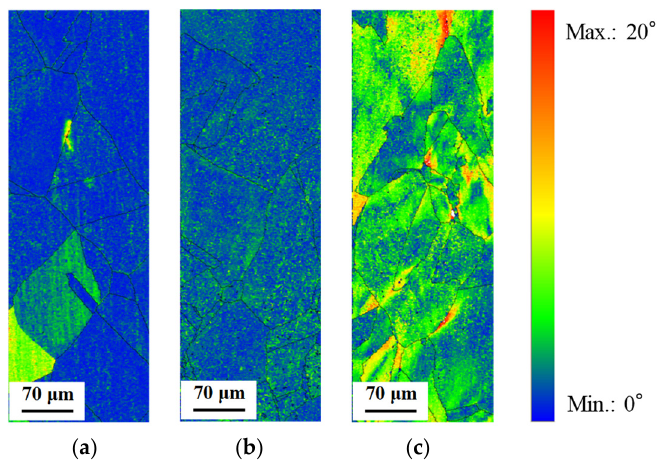
Figure 13. Grain reference orientation deviation (GROD) maps of heat-treated C1020 specimens after low cycle fatigue test. ( a ) Stress amplitude: 50 MPa (fatigue cycle: 7,786,201 cycles); ( b ) stress amplitude: 75 MPa (fatigue cycle: 235,144 cycles); ( c ) stress amplitude: 100 MPa (fatigue cycle: 49,676 cycles).